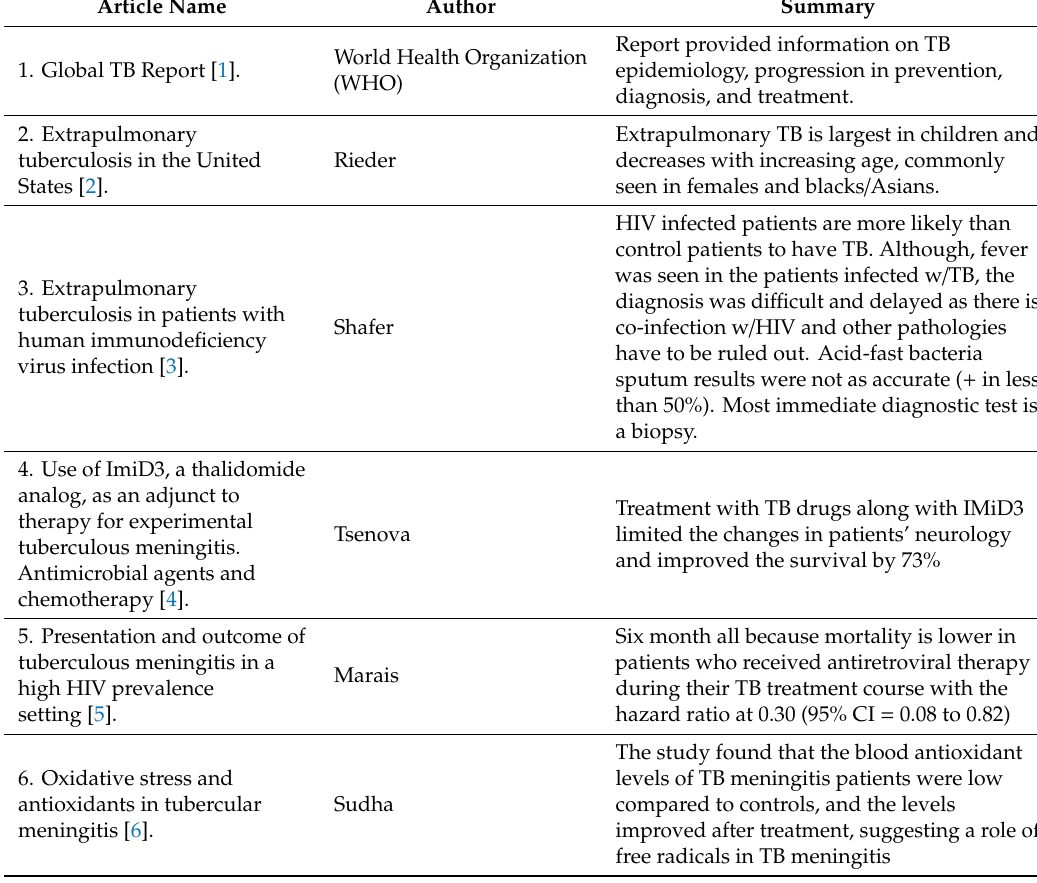
Table 1. Analysis of TB meningitis Pathogenesis, Diagnosis and